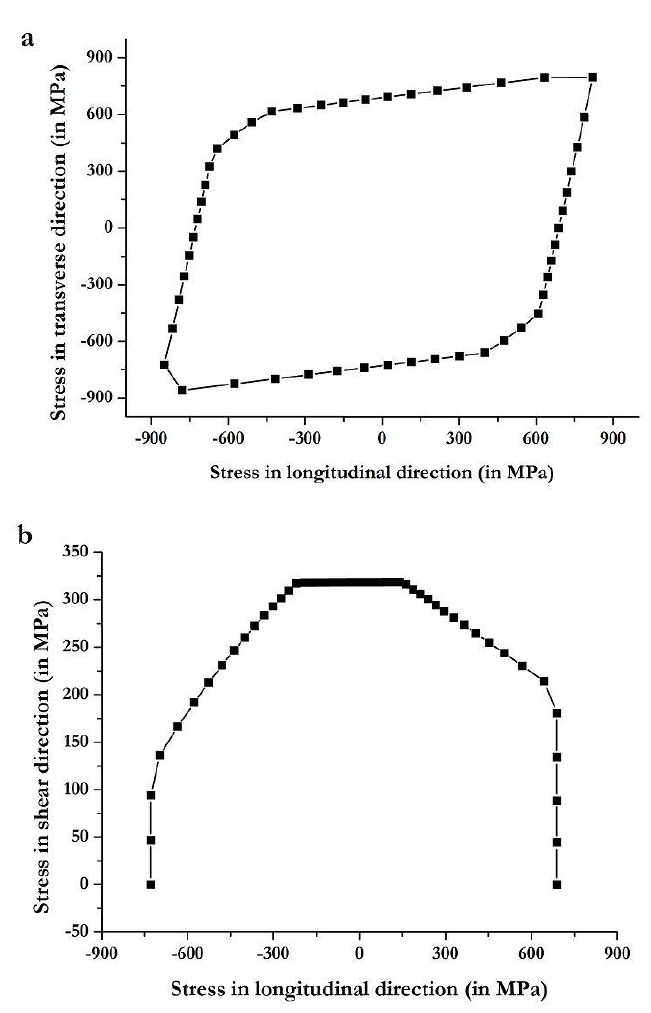
Figure 11. Failure envelope of the composite substrate in ( a ) transverse versus longitudinal direction, and ( b ) shear versus longitudinal direction, as computed with the Autodesk Helius tool.